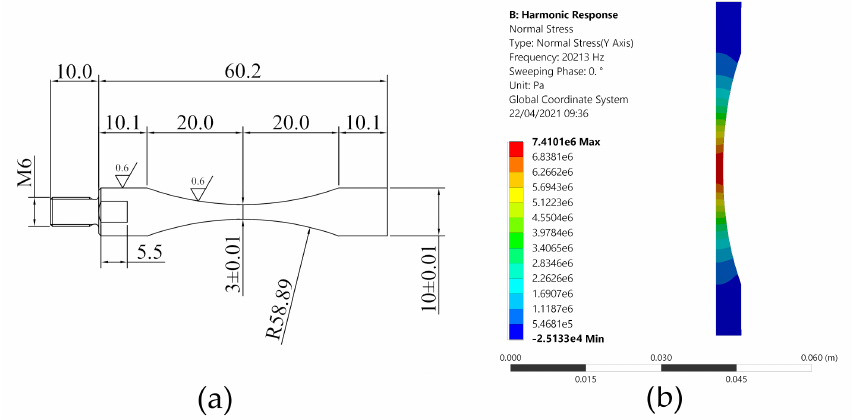
Figure 3. Specimen of 3 mm in diameter: ( a ) specimen geometry; ( b ) results of the numerical analysis.